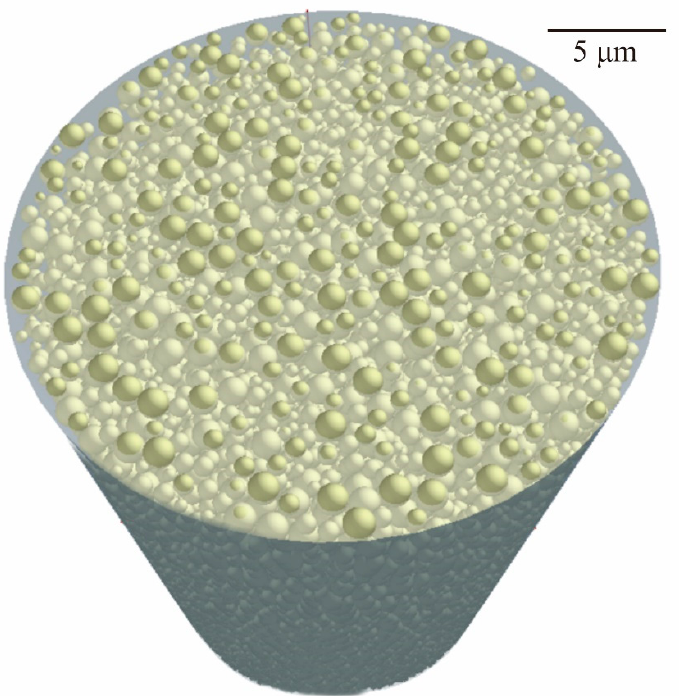
Figure 4. Dispersion profiles of bimodal powders in resin matrixes. Maximum contents were optimized at 80% of the total volume fraction. Computer graphics were plotted according to the DEM simulations.